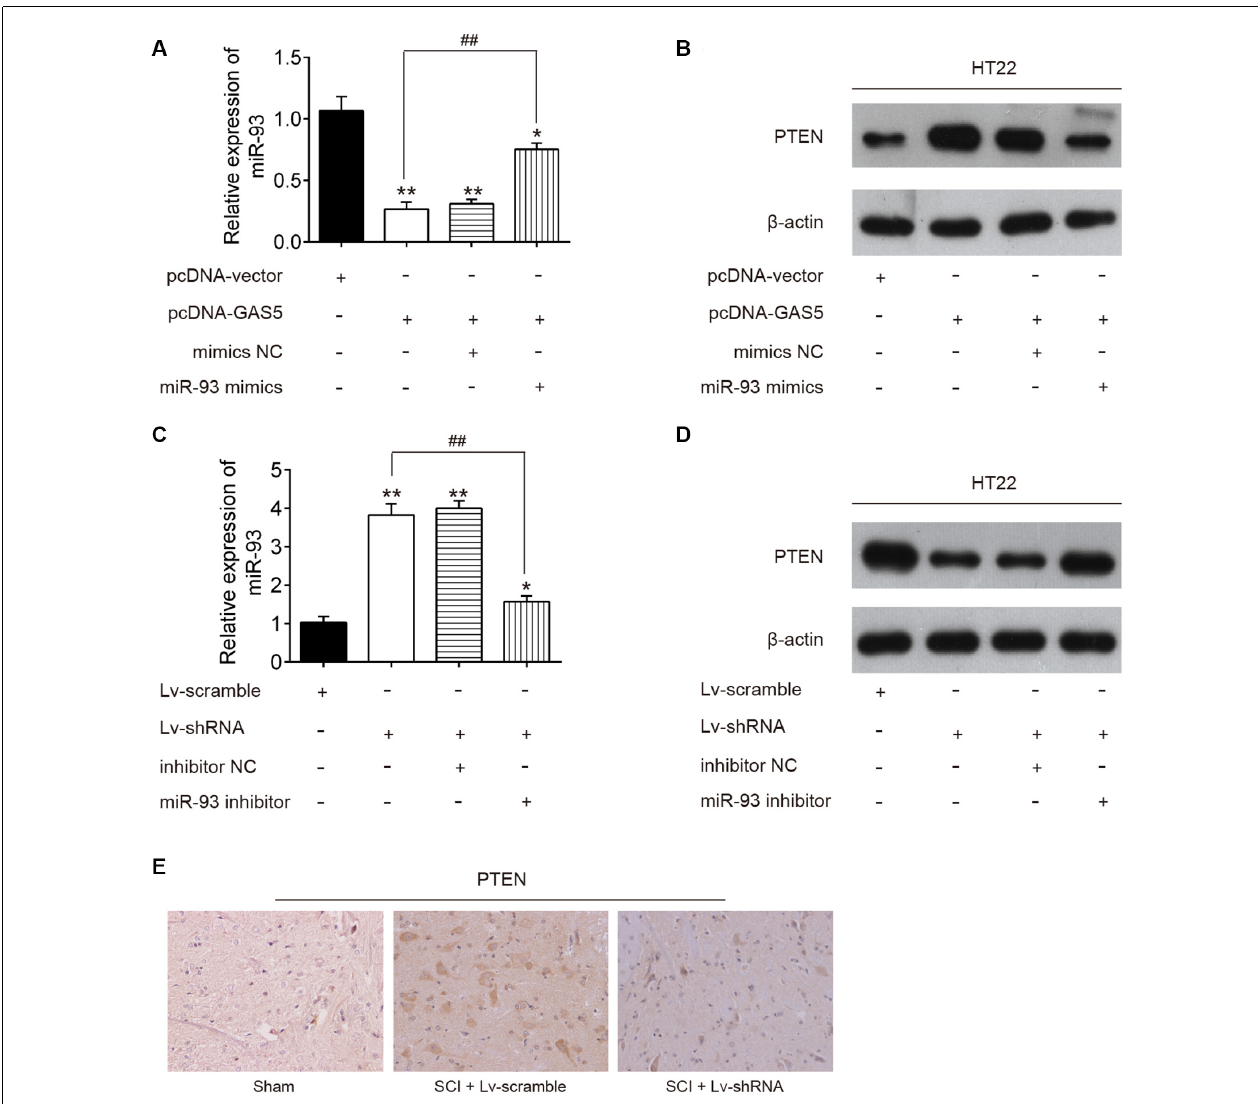
FIGURE 6 | Long noncoding RNA (lncRNA) growth arrest–specific transcript 5 (GAS5) regulates the expression of phosphatase and tensin homolog (PTEN) through sponging miR-93. The pcDNA vector and pcDNA-GAS5 alone or together with miR-93 mimics or mimics negative control (NC) was transfected into HT22 cells. Twenty-four hours after transfection, the expression levels of miR-93 and PTEN protein levels in HT22 cells were measured by quantitative reverse transcription polymerase chain reaction (qRT-PCR) and Western blot analysis. (A,B) Data represent the mean ± SD of three independent experiments. * p < 0.05, ** p < 0.01 vs. pcDNA-vector group; ## p < 0.01 vs. pcDNA-GAS5 group. (C,D) Lentivirus (LV)-scramble and lv-short-hairpin RNA (shRNA) alone or together with miR-93 inhibitor or inhibitor NC was transfected into HT22 cells; 24 h after transfection, the expression levels of miR-93 and PTEN protein levels in HT22 cells were measured using qRT-PCR and Western blot analysis. (E) The expression of PTEN was detected in spinal cord tissues of SCI mice after LV-shRNA injection.